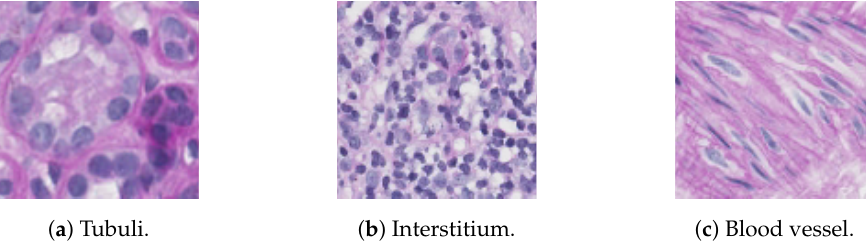
Figure 6. Example of non-Glomerulus regions belonging to tubuli, interstitium and blood vessels